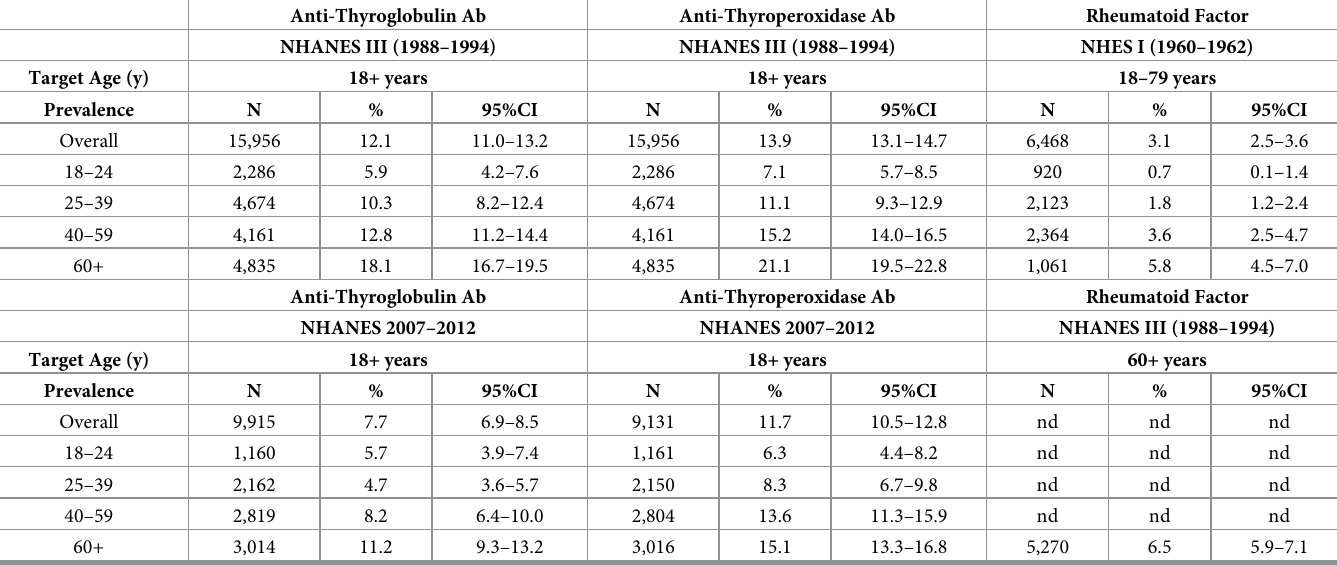
Table 2. US population prevalence of thyroid autoantibodies and rheumatoid factor,